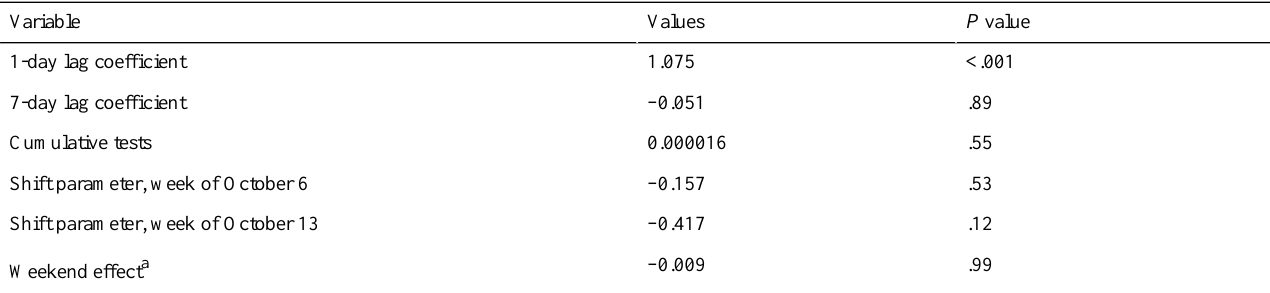
Table 1. Arellano-Bond dynamic panel data modeling of the number of daily infections reported by country in Central Asia from September 30 to